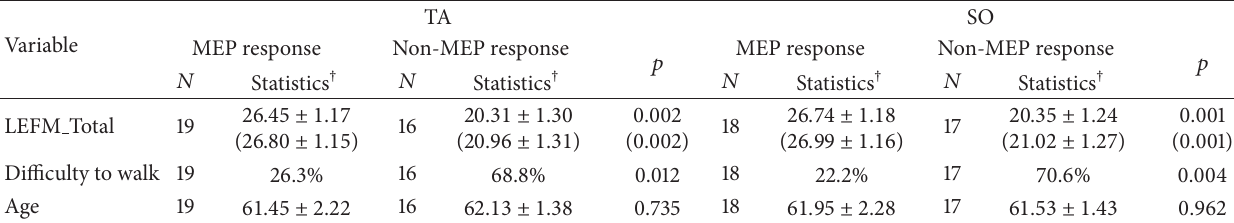
Table 3: LEFM and difficulty to walk versus MEP